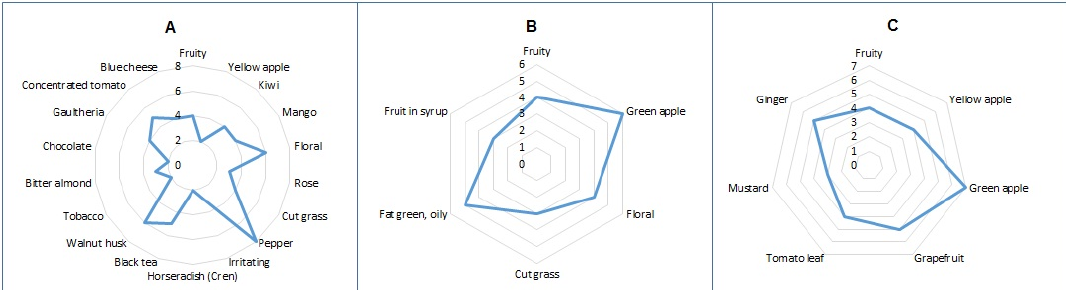
Figure 7. Aroma profile of three different species of pepper chosen as example from descriptive sensory analysis on line scale ( n = 10). Panel ( A ) shows sample 1 (Naga Morich, Capsicum chinense ); panel ( B ) shows sample 14 (Calabrian pepper, Capsicum annuum ); and panel ( C ) shows sample 17 (Aji, Capsicum baccatum ).